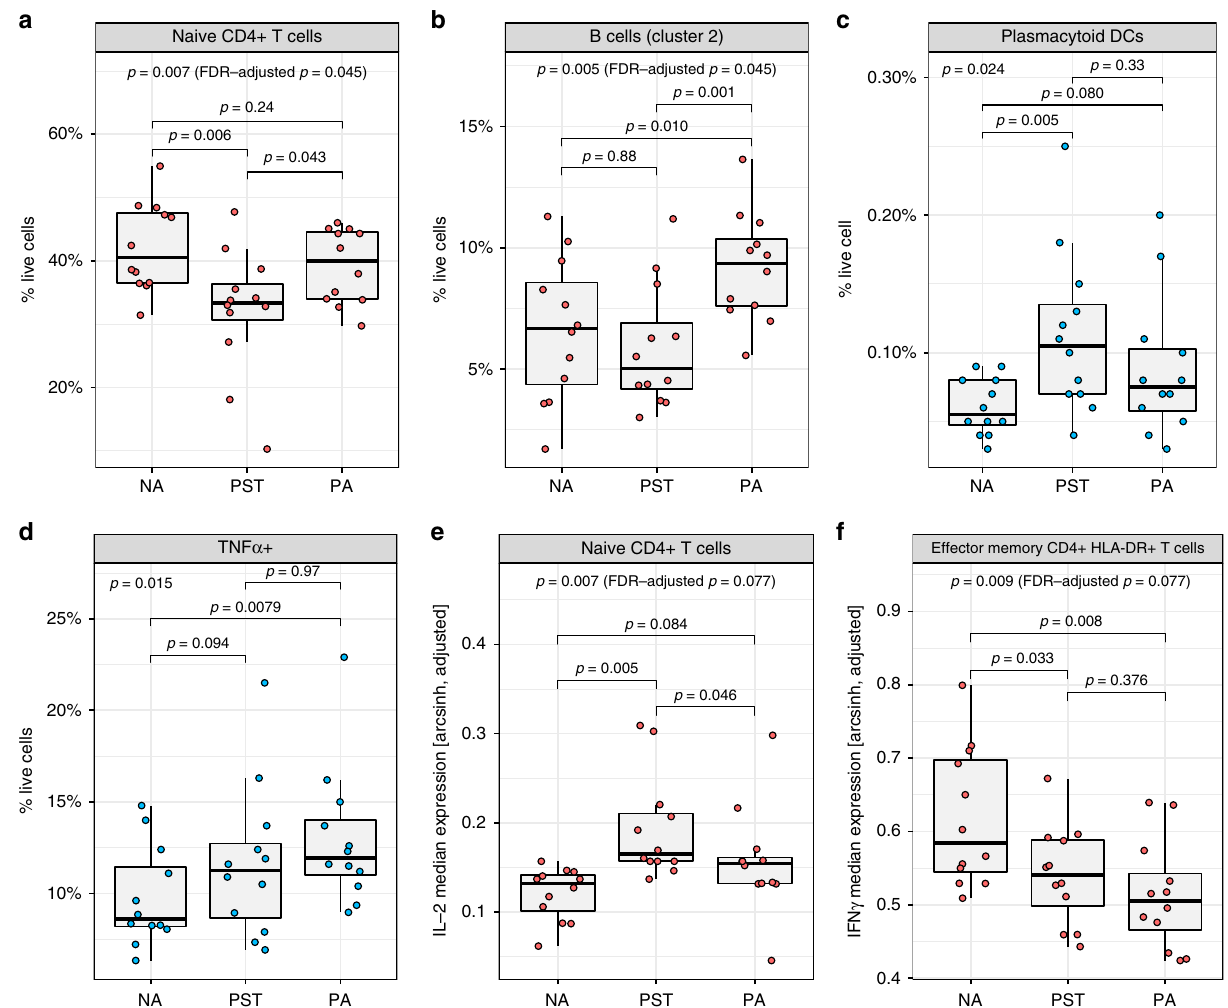
Fig. 4 Unsupervised and manual gating analysis of resting and PMA/ionomycin-stimulated PBMCs reveals differences in multiple immune signatures between non-allergic (NA), peanut-sensitized tolerant (PST), and peanut-allergic (PA) infants. Frequency (as % of live cells) of ( a ) naive CD4 T-cell cluster and ( b ) B-cell cluster 2 (CD19 ++ HLADR ++ ) identi fi ed by unsupervised analysis in unstimulated PBMCs from NA, PST, and PA infants. c , d Frequency (as % of live cells) of resting plasmacytoid DCs (CD123 + CD11c − ) and TNF- α + cells as identi fi ed by manual gating from NA, PST, and PA infants. Median expression of ( e ) IL-2 in the naive CD4 T-cell cluster and ( f ) IFN γ in effector memory HLADR + CD4 T-cell cluster as identi fi ed by unsupervised analysis in NA, PST, and PA infants. P -values by χ 2 -tests in mixed-effects model analyses, between the three groups and post-hoc pairwise. Median expression values were adjusted for batch before plotting. Blue dots represent values determined by manual gating, whereas red dots represent values derived from the unsupervised analysis. In the boxplots, the medians are shown. The “ hinges ” represent the fi rst and third quartile. The whiskers are the smallest and largest values after exclusion of outliers (greater than the 75th percentile plus 1.5 times the IQR or less than 25th percentile minus 1.5 times the IQR). Source data are provided as a Source Data fi